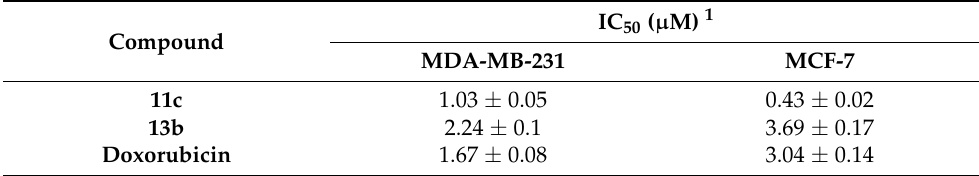
Table 3. Anti-proliferative action of QBS 11c and 13b against breast MDA-MB-231 and MCF-7 cancer cell